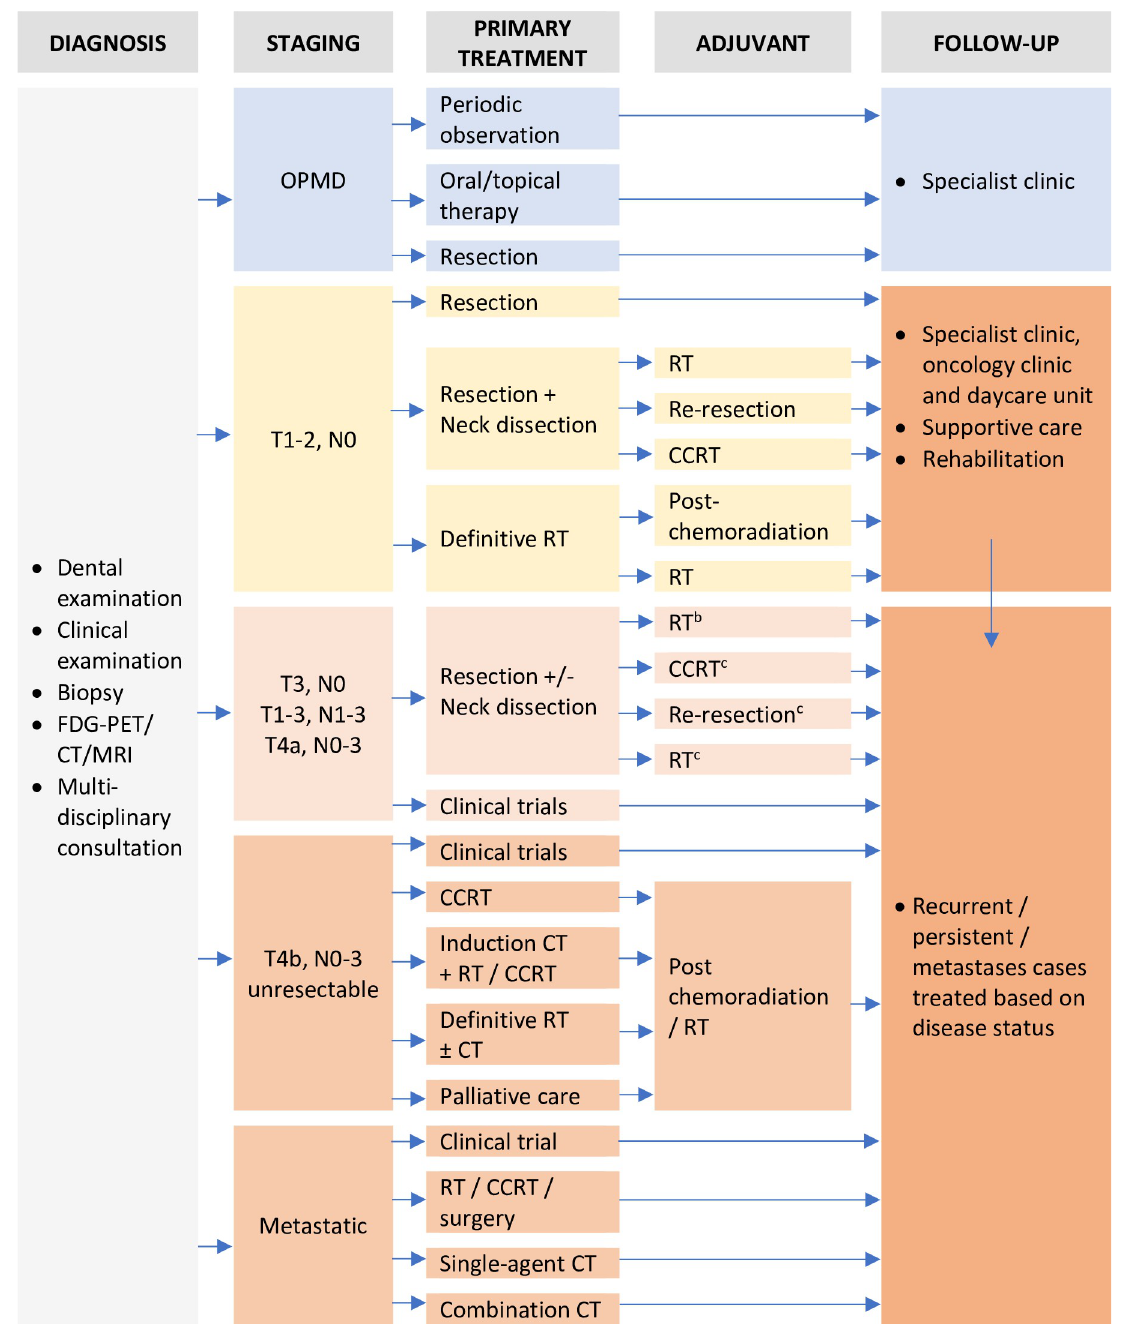
Fig 2. Simplified clinical pathway of the patient journey in a public healthcare facility. � Note: The pathway shown is for the treatment of cancer in the buccal mucosa, floor of the mouth, tongue, alveolar ridge, hard palate. a FDG-PET = fluorodeoxyglucose-positron emission tomography, CT = computed tomography, MRI = magnetic resonance imaging, RT = radiotherapy, CCRT = concurrent chemotherapy and radiotherapy. b Presence (and based on) adverse risk features. c No adverse features.